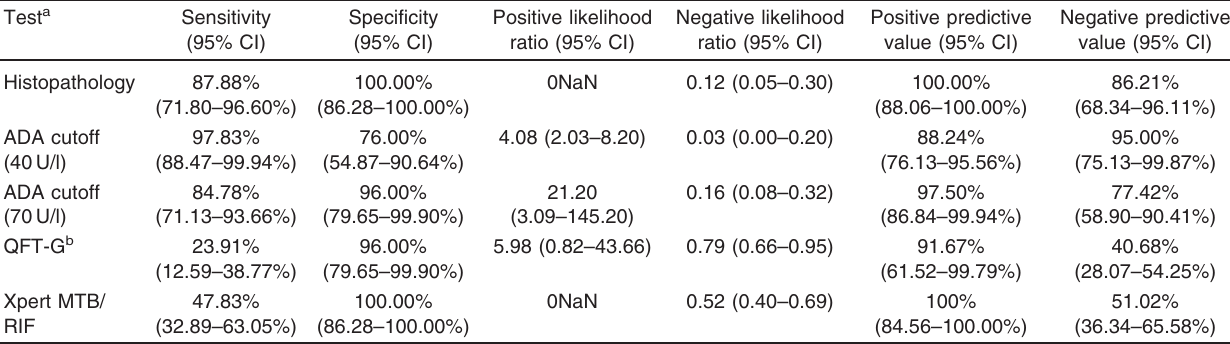
Table 2 Sensitivity and specificity of histopathology, adenosine deaminase with two cutoff values (40 and 70U/l), QFT-G, and Xpert MTB-RIF